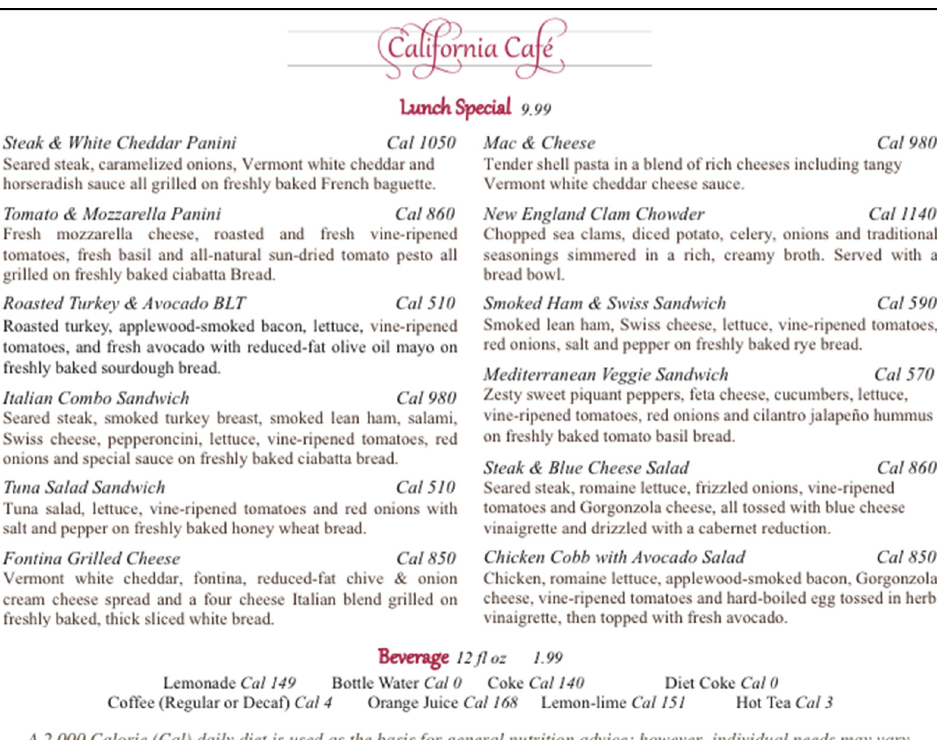
Figure A5. California Cafe Control Menu.